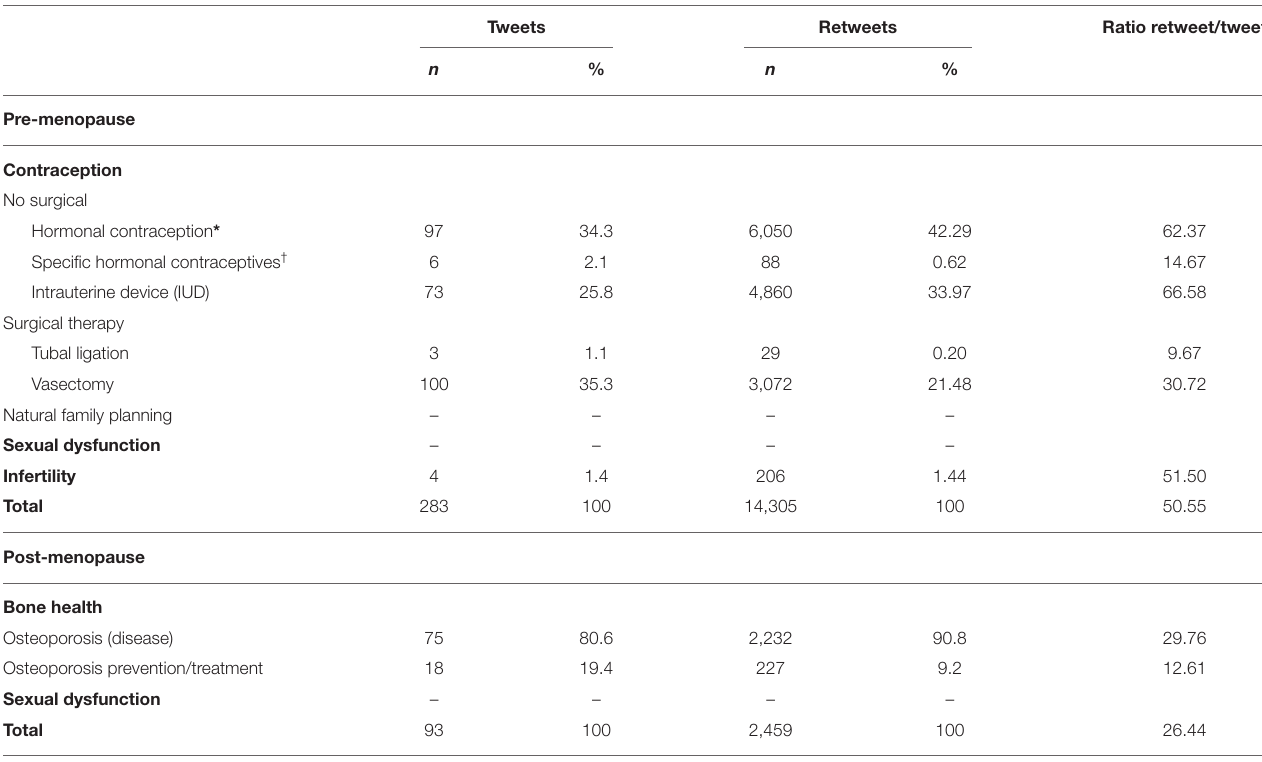
TABLE 3 | Number of tweets and retweets generated in pre-menopause and post-menopause.